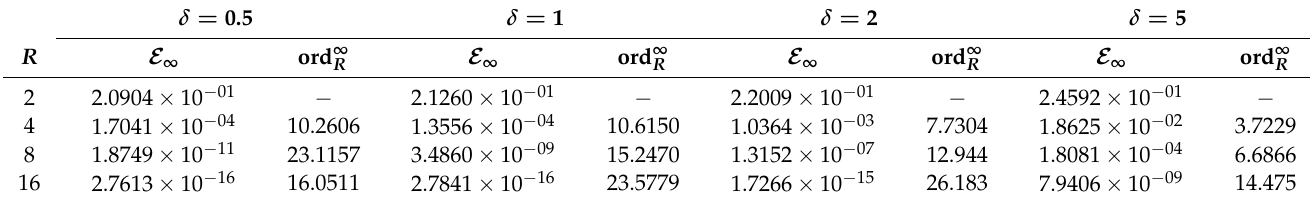
Table 7. The outcomes of θ = 1.5, λ = 0.5, α = θ , and different R